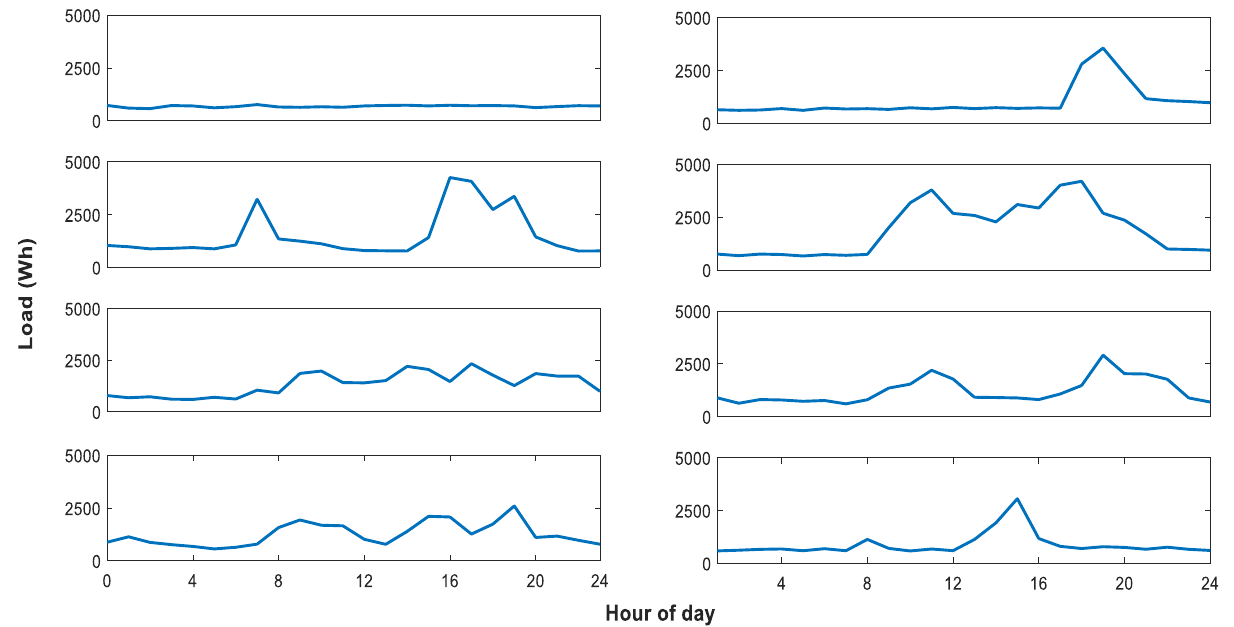
Fig. 6. Daily load pro fi les of the Household 8 between Jan 01 and Jan 08